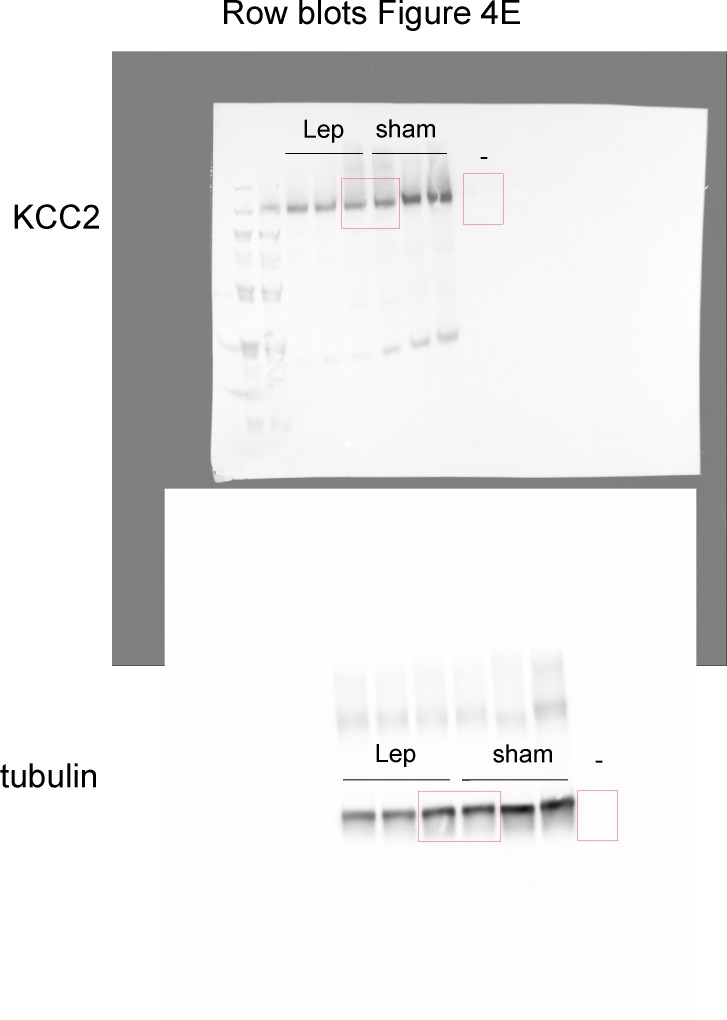
Raw blots for panel E (Lep and sham).